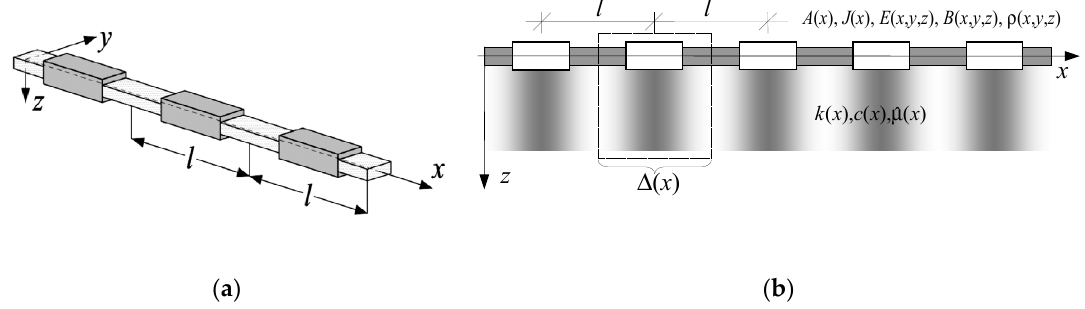
Figure 1. Fragments of periodic beams: ( a ) without foundation; ( b ) on a foundation.